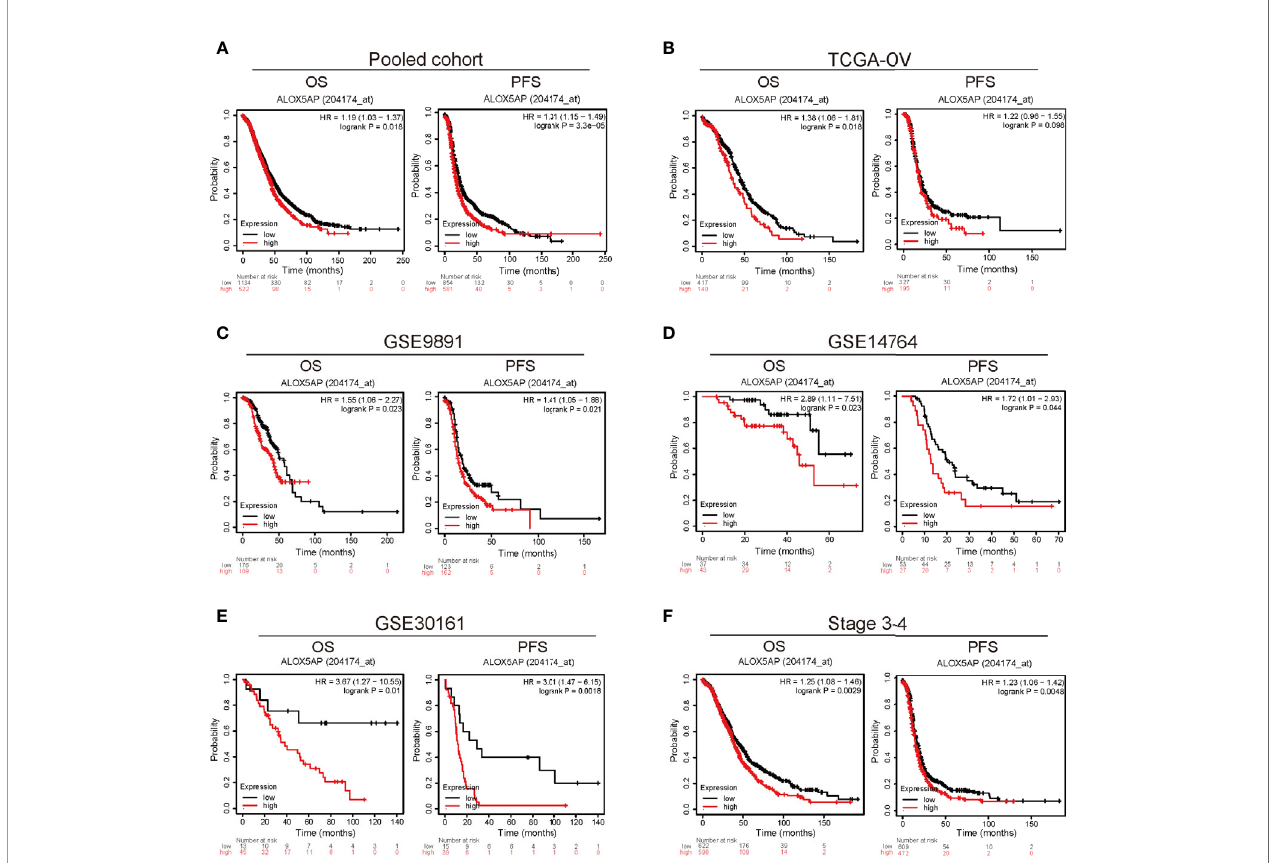
FIGURE 2 | Survival analysis comparing the high and low expression of ALOX5AP in different ovarian cancer cohorts. Survival curves of OS and PFS for (A) pooled ovarian cancer patient cohorts, (B) TCGA-OV cohort, (C) GSE9891 datasets (D) GSE14764 datasets, (E) GSE30161 datasets. and (F) stage 3-4 ovarian cancer patient cohorts. (OS, overall survival; PFS, progression free